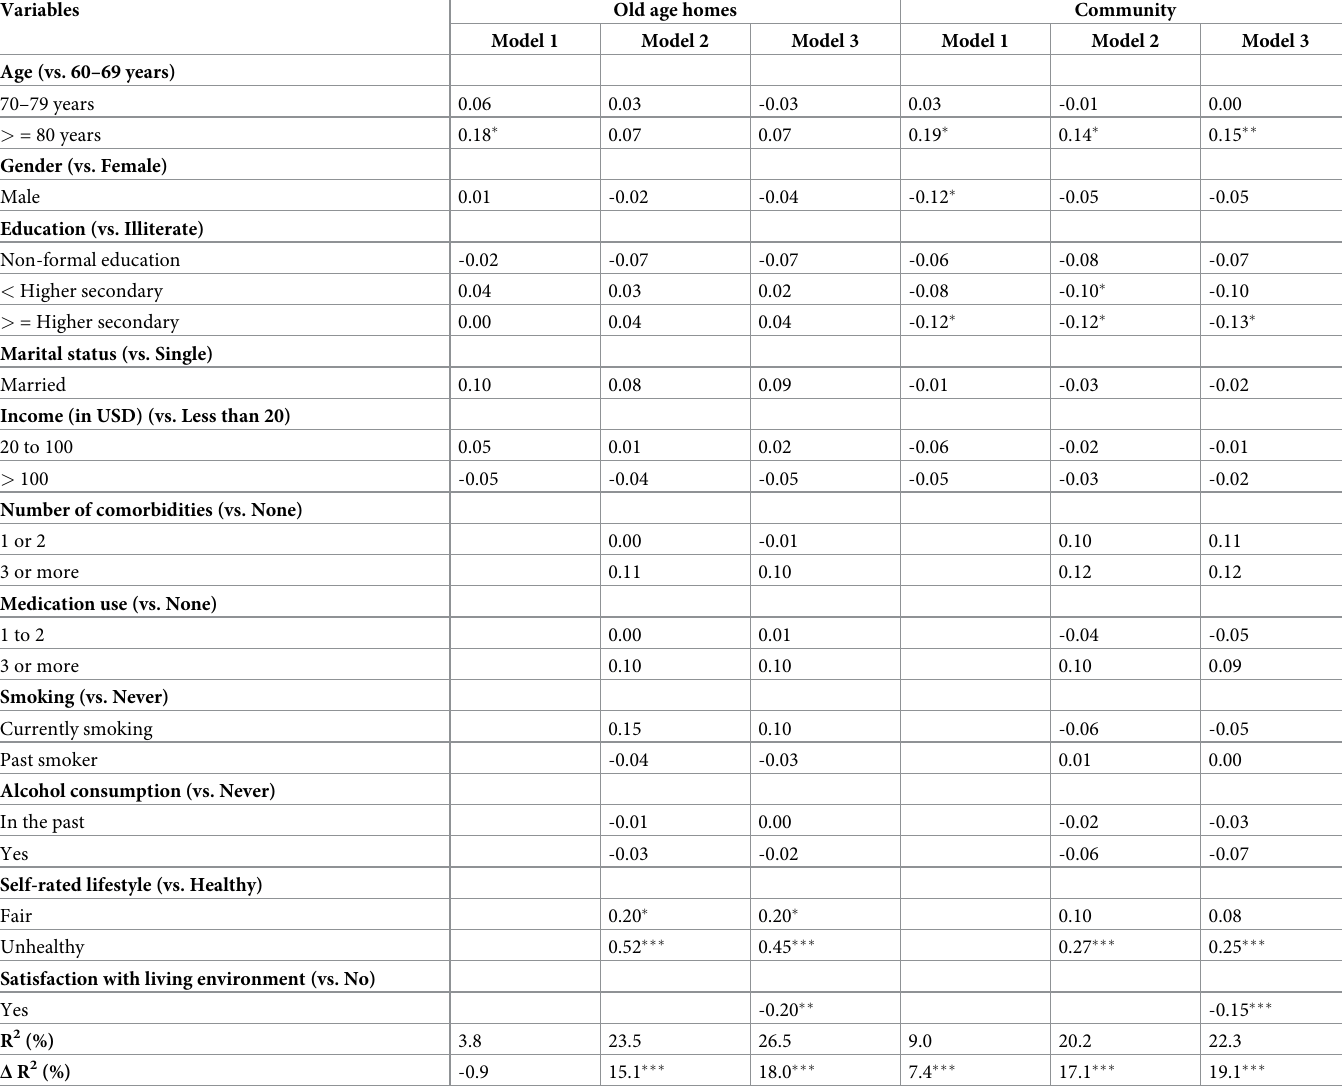
Table 4. Hierarchical regression analyses: Factors associated with overall GFI in old age homes (n = 193) and the community (n = 501).